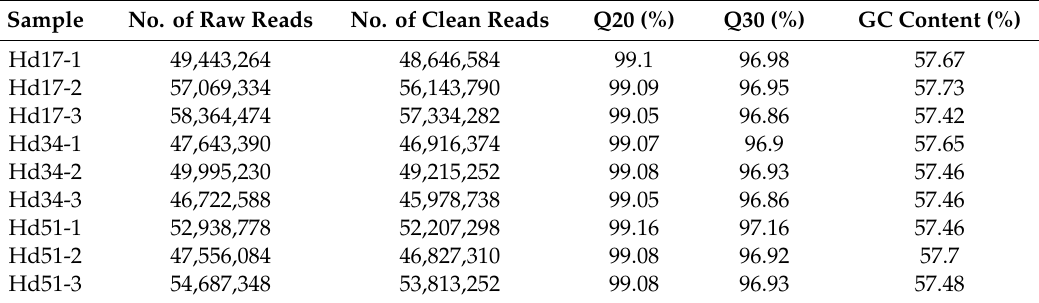
Table 1. Throughput and quality of RNA-seq of samples